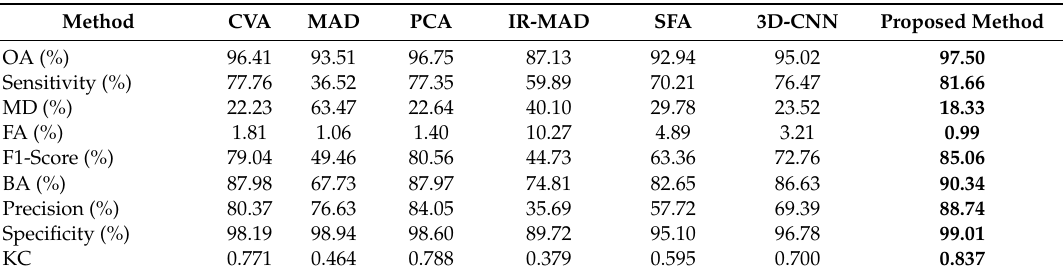
Table 10. The accuracy of different change detection methods for the Hyperspectral-River dataset (the best performance for each method appears in bold).